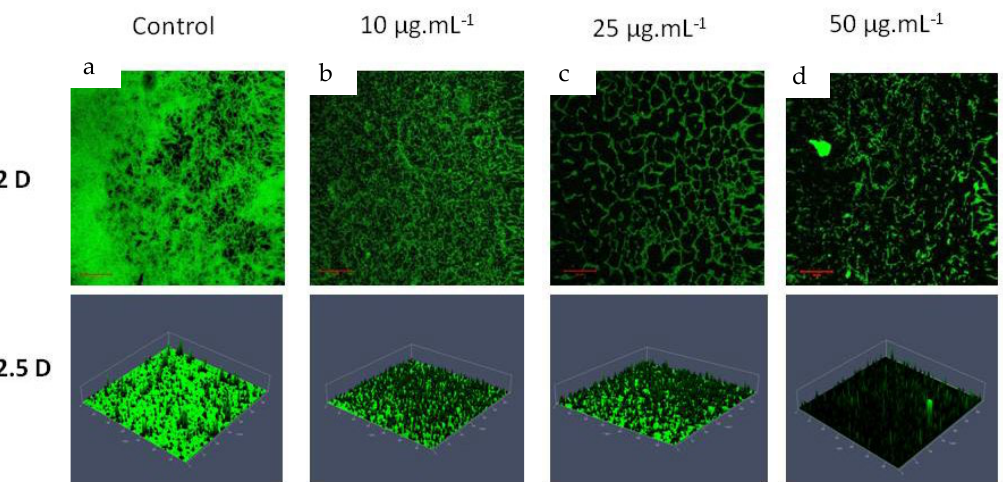
Figure 5. CLSM analysis showing the biofilm inhibitory potential of HANPs against P. aeruginosa ATCC 10145 at increasing concentrations. Control, treated with HANPs at 0 µ g mL − 1 ( a ); biofilm formed in the presence of HANPs at 10 µ g mL − 1 ( b ), 25 µ g mL − 1 ( c ), and 50 µ g mL − 1 ( d ).